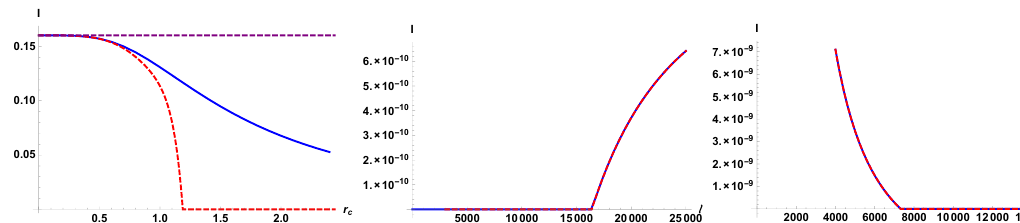
Figure 15 . HMI for very large entangling regions, i.e. ‘ (cid:29) r c : Left ) as a function of r c for l = 10 4 , h = 1 and d e = 3 . The purple dashed curve indicates the HMI for the zero cutoff case given in eq. (4.9). The solid blue curves are numerical results based on eq. (3.17), and the red dashed curves are based on the perturbative expression given in eq. (3.22), which is valid for very large entangling regions. Middle ) as a function of ‘ for h = 1 . 2 × 10 4 , r = 1 and d = 3 . Right ) as a function of h c e for ‘ = 10 4 , r = 1 and d = 3 c e